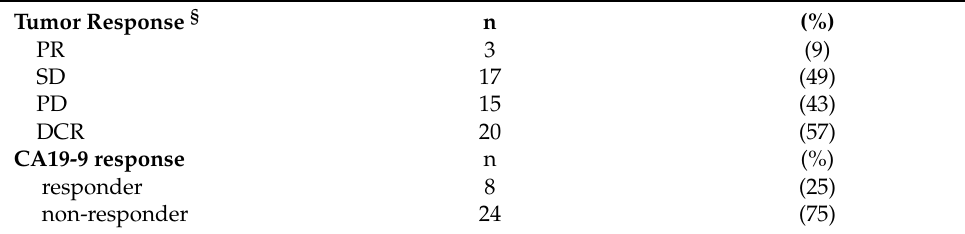
Table 3. Overall response to treatment with irinotecan plus fluorouracil/folinic acid (nal-IRI/FF). Tumor Response